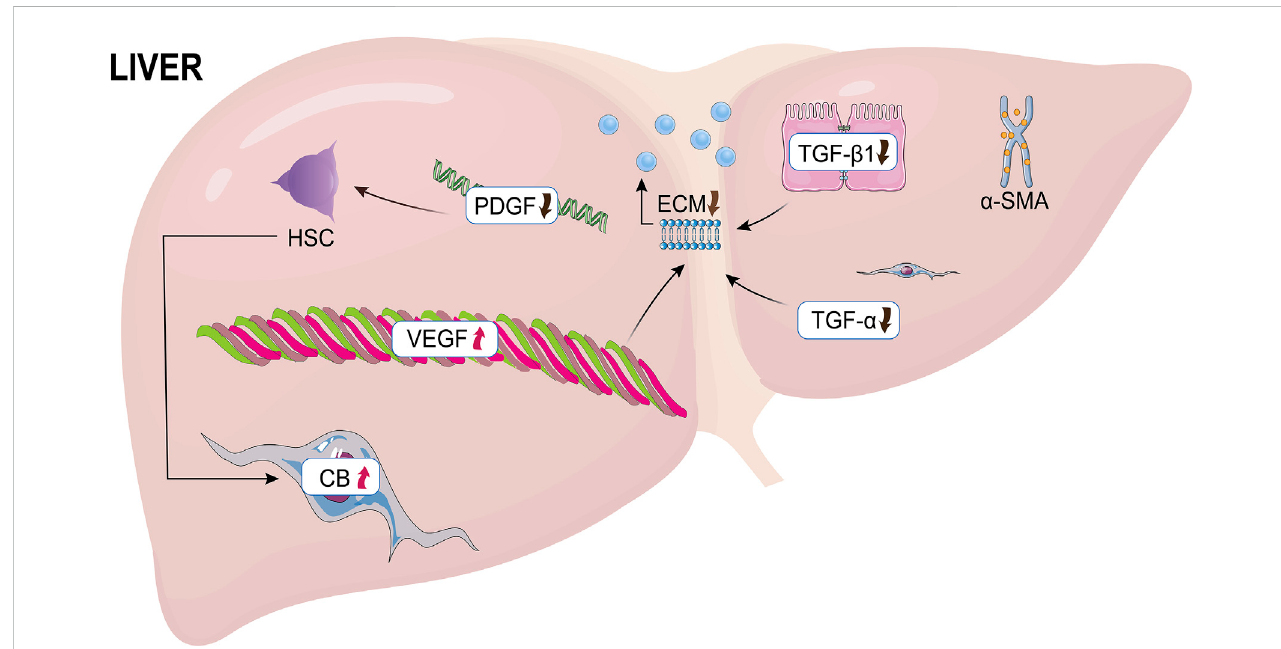
FIGURE 2 The causes of liver fi brosis. HSC, hepatic stellate cells; PDGF, Platelet-derived growth factor; ECM, extracellular matrix; VEGF, vascular endothelial growth factor; CB, cannabinoid.